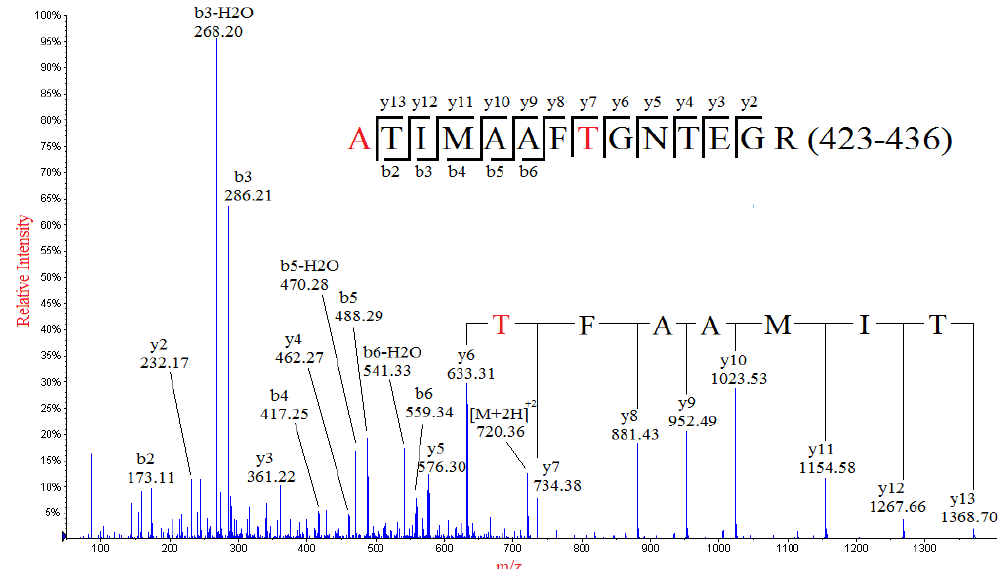
T → A, T → A, E → T. The detection of the y series ion y 13 at m / z 1368.66, as well as b 423 433 434 -H O and b ions, indicated that the first three residues in the peptide were ATI, thus confirming the b 2 2 2 identification of substitution of T → A. Therefore, the peak MP2 was identified as the tryptic peptide 423 in the residues from 423 to 436 with the two substitutions, namely T Figure 3. MS/MS spectrum of the doubly-charged ion at m / z 720.36 from the analysis of peak MP2. The mutated peptide (ATIMAAFTGNTEGR) of a normal sequence (residues 423–436) from tryptic digestion of nucleocapsid protein was identified, in which the T423 and N430 were substituted with A and T, respectively.